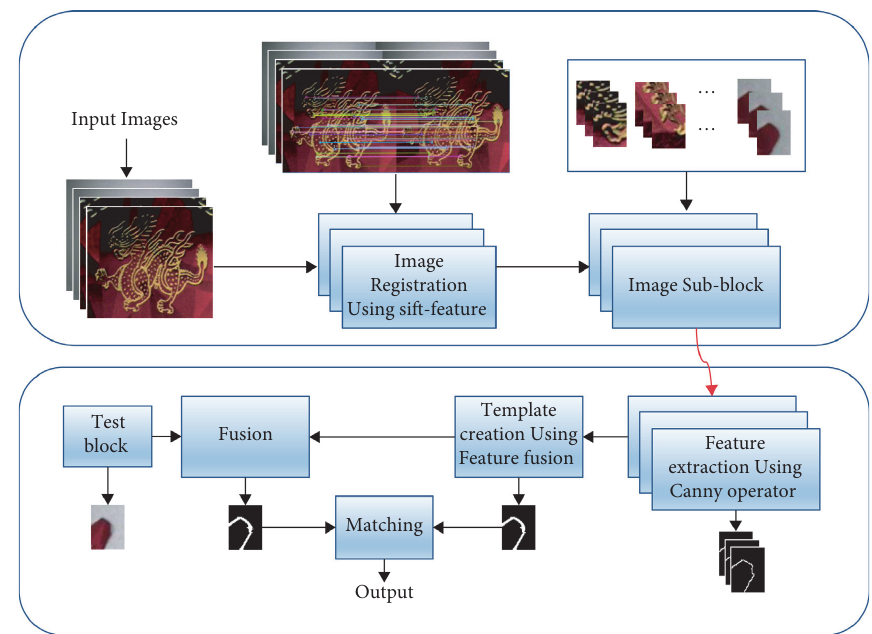
Figure 3: The architecture of the proposed defect detection system.